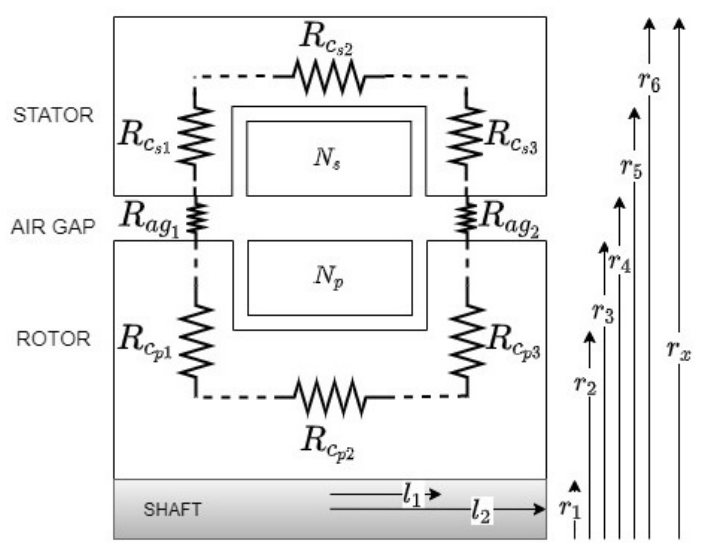
Figure 3. Parametric model of an axial air-gap rotary